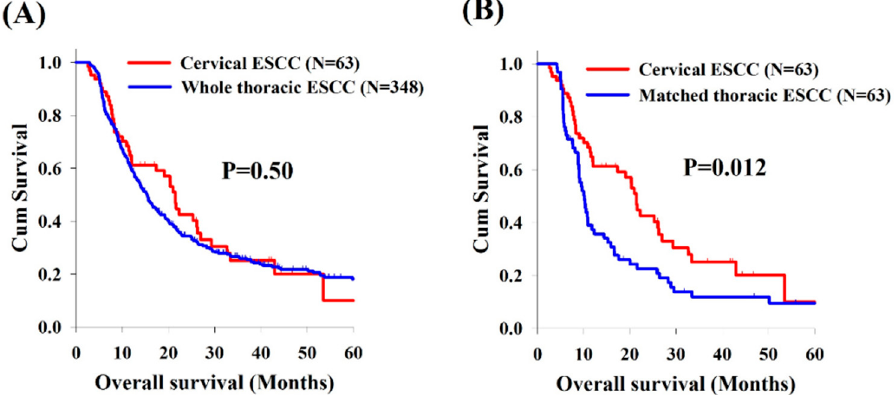
Figure 1. Kaplan–Meier curves comparing overall survival between patients with cervical and thoracic esophageal squamous cell carcinoma (ESCC). ( A ) Cervical ESCC group versus whole thoracic ESCC group. ( B ) Cervical ESCC group versus matched thoracic ESCC group.